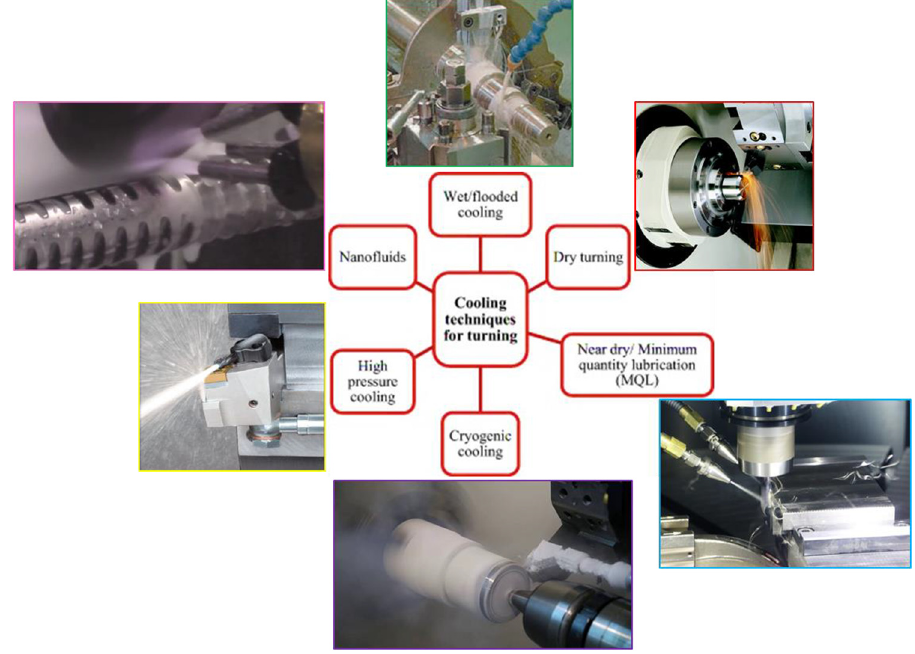
Fig. 7. Cooling techniques in turning hard